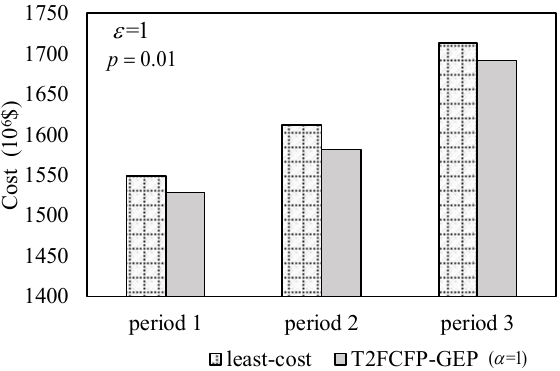
(b) The intermittent characteristics of renewable energy availability parameters could be expressed